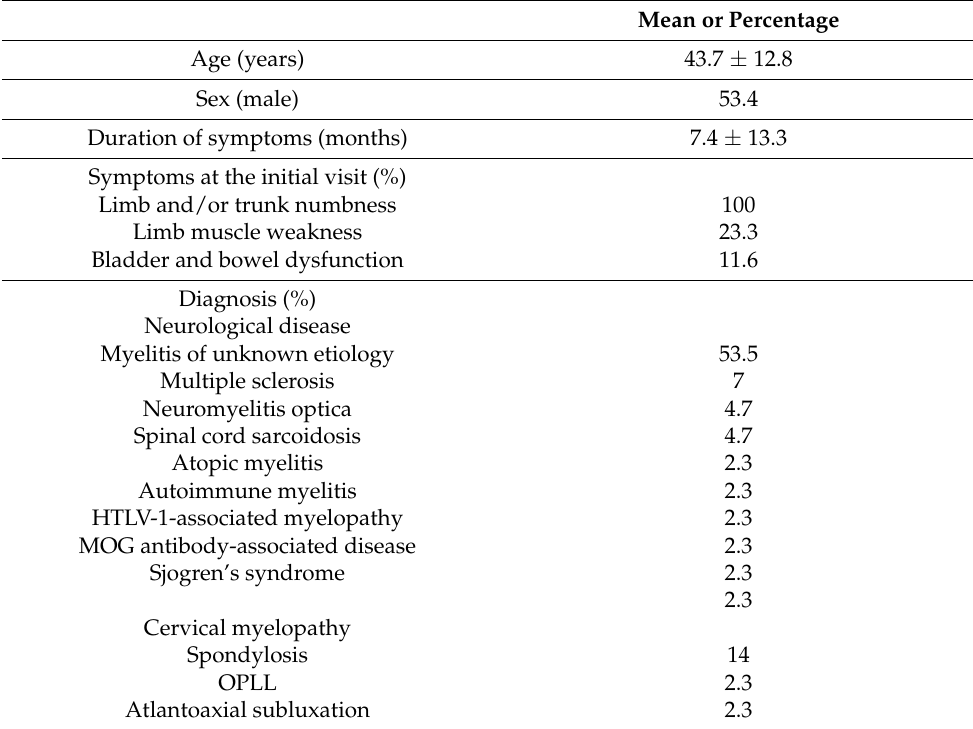
Table 1. Demographic characteristics and diagnoses of 43 patients with non-neoplastic intramedullary lesions.